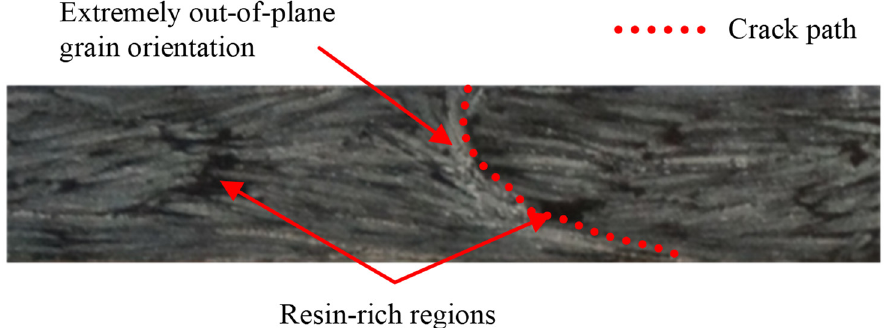
Figure 9. Side view of a RA2557516 specimen showing out-of-plane grain orientation. In contrast, comparing the average tensile modulus of the two panels showed no significant difference (t(16) = 1.65, p > 0.05). Since the tensile modulus is an averaged volumic